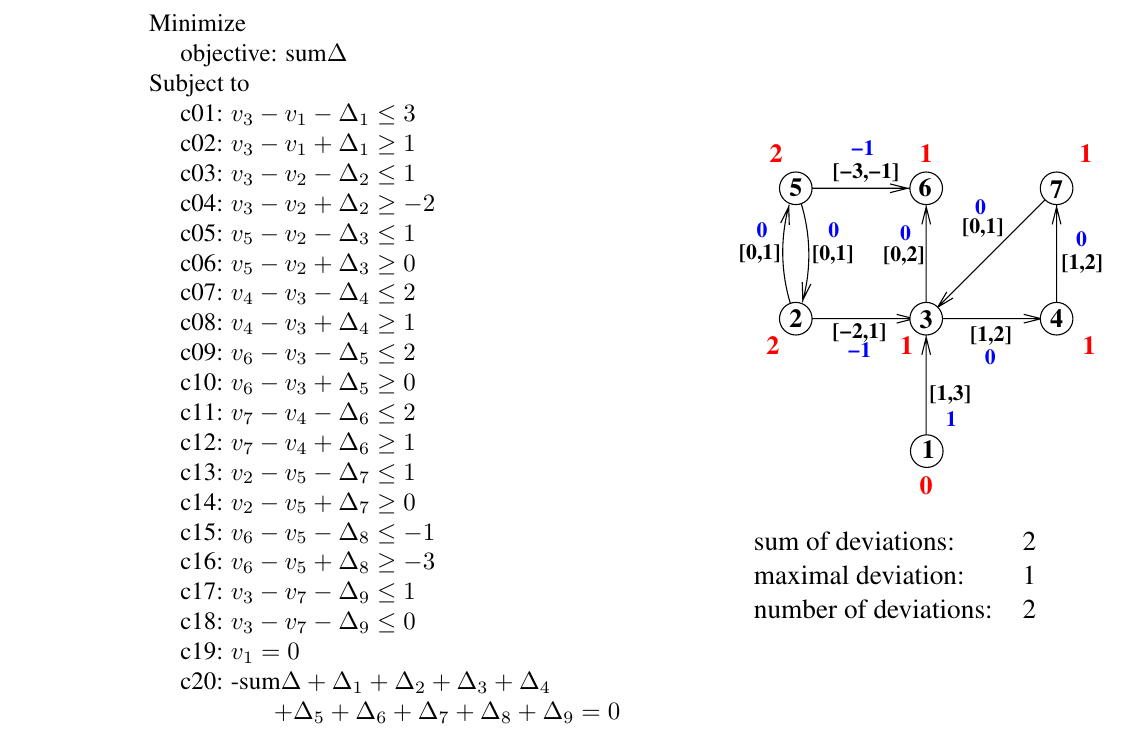
FIGURE 3 | Left: The linear program to calculate an optimal hierarchy for the graph from Figure 1. The objective is to minimize the sum of all deviations (defi ned by constraint c20). Right: The resulting hierarchy. Red numbers are the hierarchy levels of nodes, blue numbers the actual distances in the